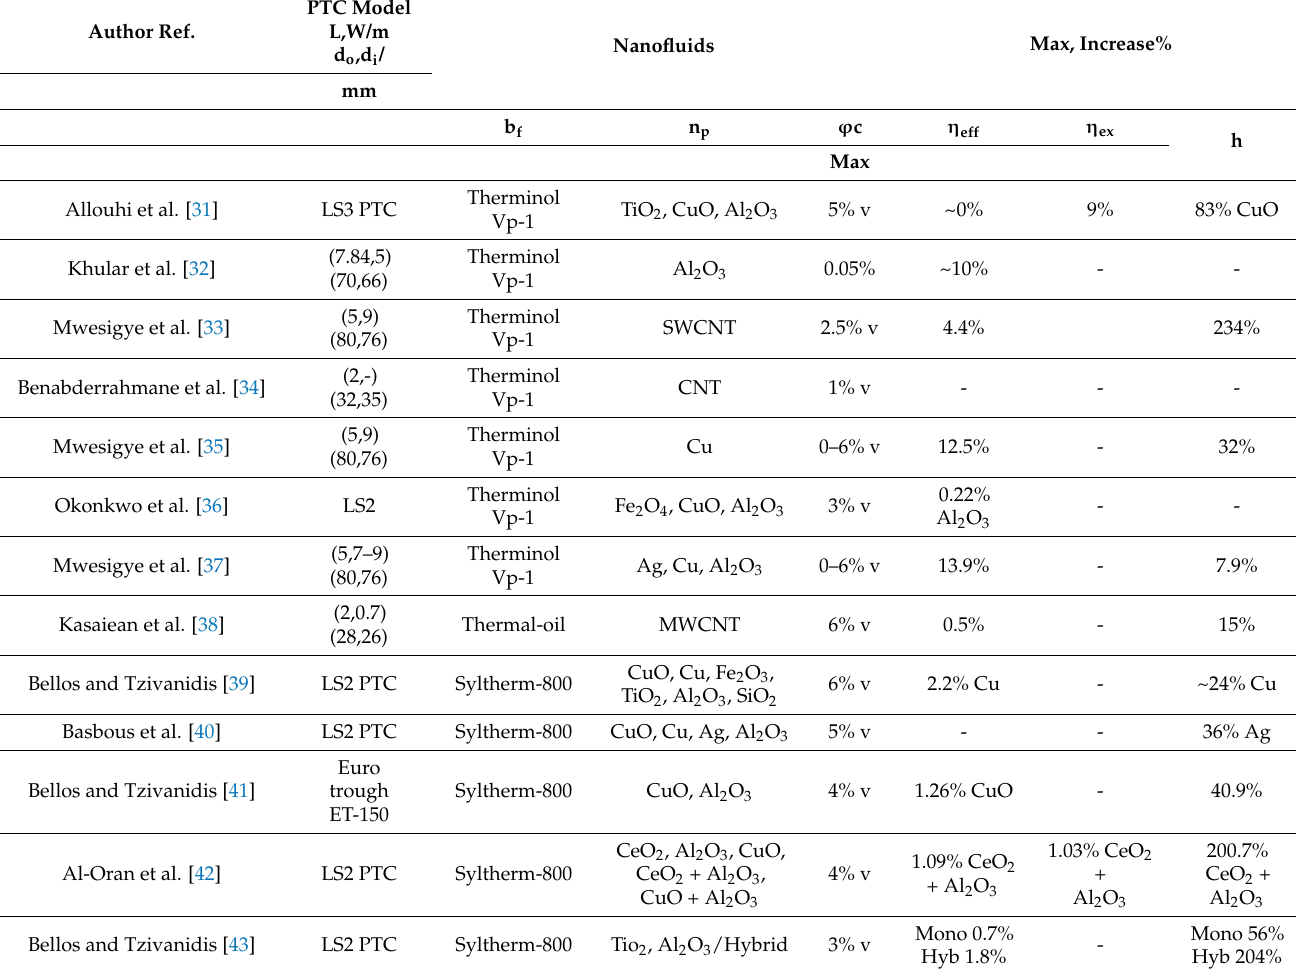
Table 1. Theoretical studies that used nanoparticles with a base of